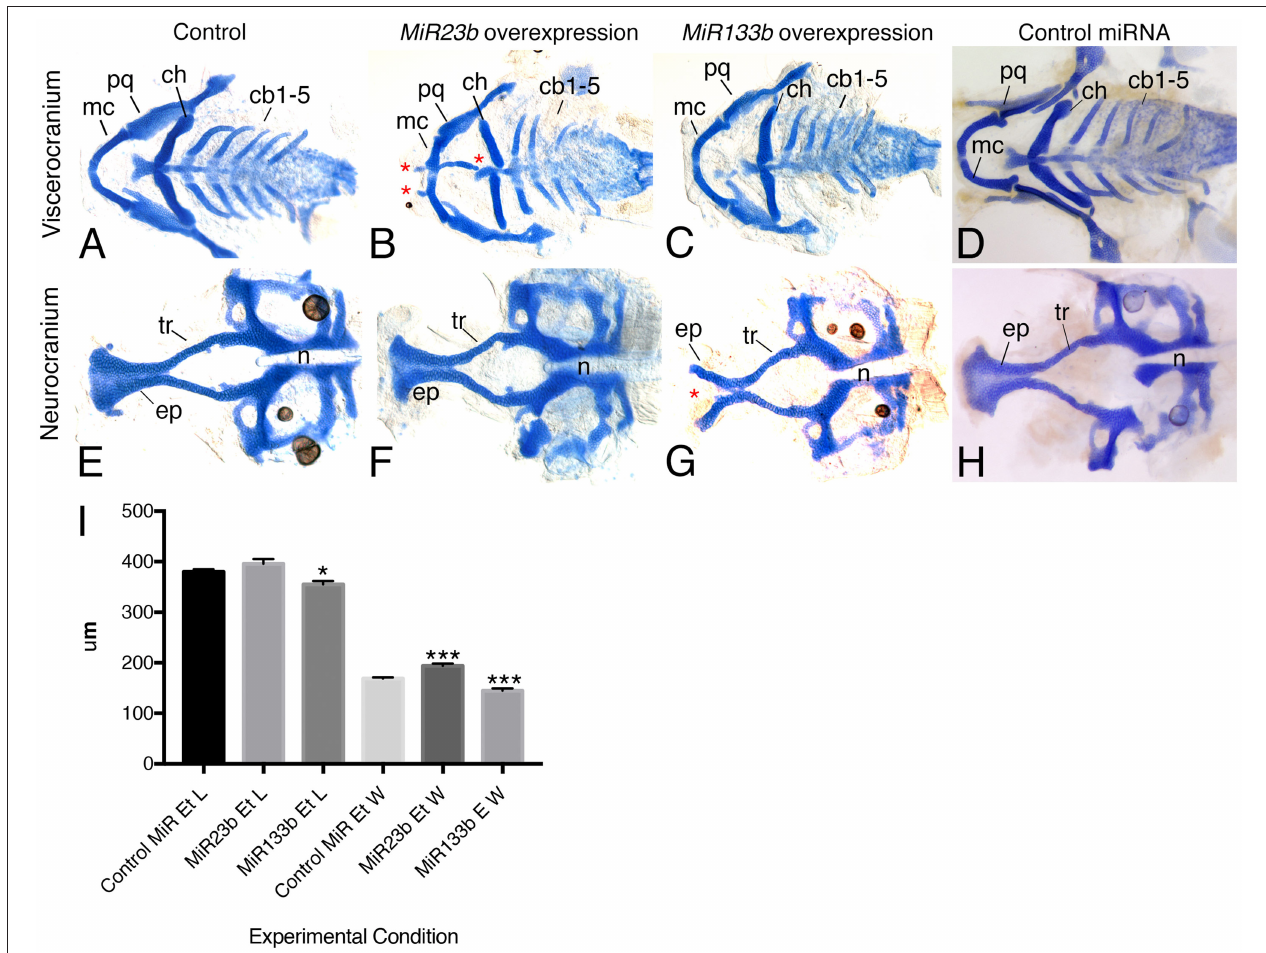
FIGURE 7 | Injection of MiR133b and MiR23b RNA duplexes resulted in facial defects. Alcian blue stain of 6dpf zebrafish larvae, flat mounted ventral views, anterior is to the left. (A,D,E,H) Control embryos, either uninjected or 33 µ M control miR-injected, display wild type type craniofacial cartilage in both the viscerocranium and neurocranium. (B,F) Injection of 33 µ M RNA duplex of MiR23b leds to a slight increase in the width of the ethmoid plate, likely resulting from shortening of the trabeculae (tr) (F) , and production of ectopic cartilage (*; B ) in the B ) in the viscerocranium. (C,G) Injection of 6.25 µ M RNA duplex of MiR133b resulted in hypoplastic cartilage structure and a cleft (*) in the ethmoid plate (ep; G,I ) . (I) Quantification of ethmoid plate length and width comparing standard control MiR ( n = 10 ) injected with 33 µ M compared to MiR23b ( n = 9 ) and MiR133b ( n = 9 ). Elements were measured and the mean and standard deviation for each are: Ethmoid plate length for control MiR, 380 ± 13.23 µ m; MiR23b, 396 ± 27.13 µ m; and MiR133b, 355 ± 19.27 µ m; Ethmoid plate width for control MiR, 169.2 ± 4.92 µ m; MiR23b, 193.9 ± 193.9 ± 14.09 µ m; and MiR133b : 144.7 ± 14.7 µ m. Student’s (Welsh’s) T -test was used to compare to the standard control using GraphPad PRISM. * p < 0.02 and *** p < 0.0008 . Anterior is to the left. cb, ceratobranchial; ch, ceratohyal; mc, Meckel’s cartilage; n, notochord; pq,